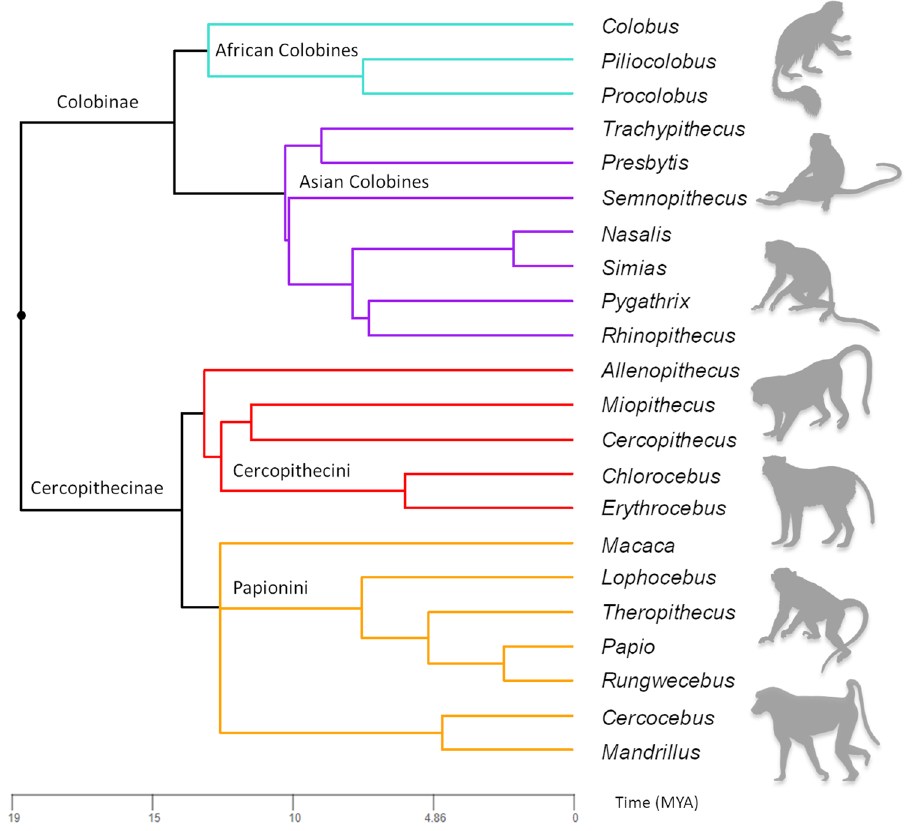
Figure 1. Phylogenetic tree depicting relationships between Cercopithecidae genera. Branch lengths are proportional to time (in millions of years [MYA]). African colobines are depicted in turquoise, Asian colobines in purple, guenons in red, and papionins in orange. Tree was constructed using a newick file downloaded from timetree.org 77 . Silhouettes taken from Phylopic.org. Image of Cercopithecus by Kai R. Casper (https:// creat iveco mmons. org/ licen ses/ by/3.